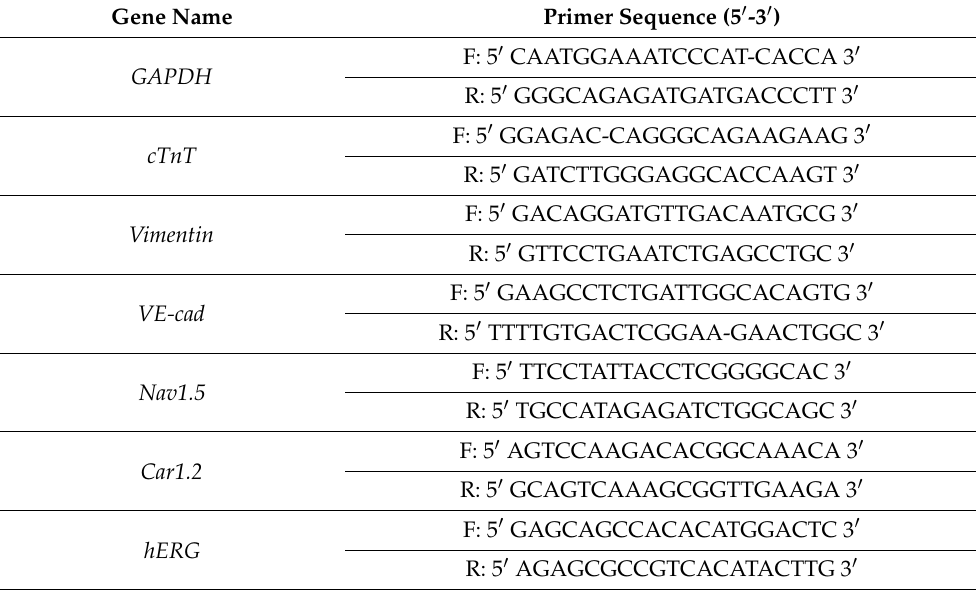
Table 1. List of the primer sequences for